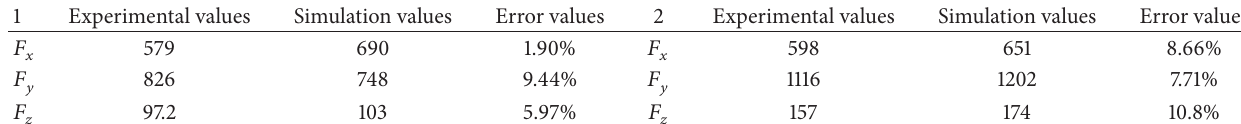
Table 2: Comparison of cutting forces between simulation and experiment.